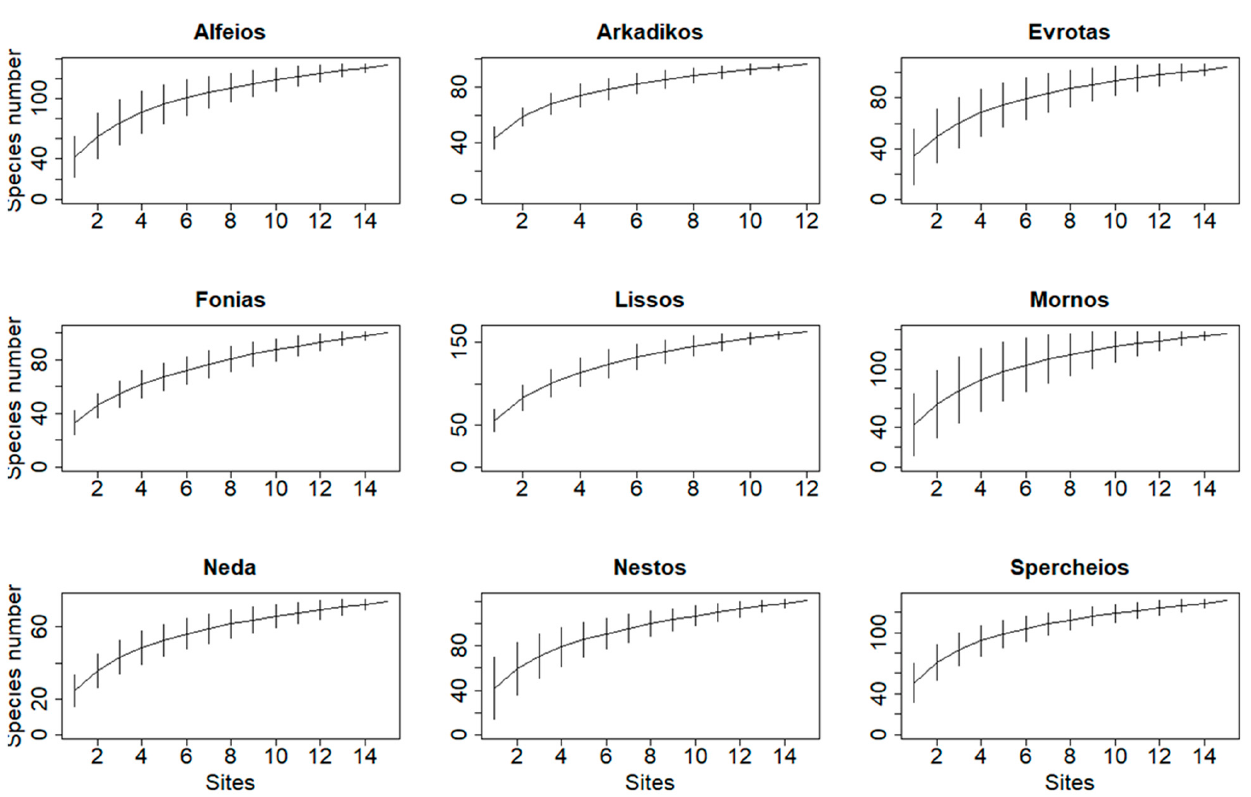
Figure A2. Species–accumulation plots for each river. When the curve reaches a plateau, we assume that sampling effort was enough to detect most of the species present. Analysis was performed in R (v. 4.0.3), using package vegan (v. 2.5 ‐ 7).